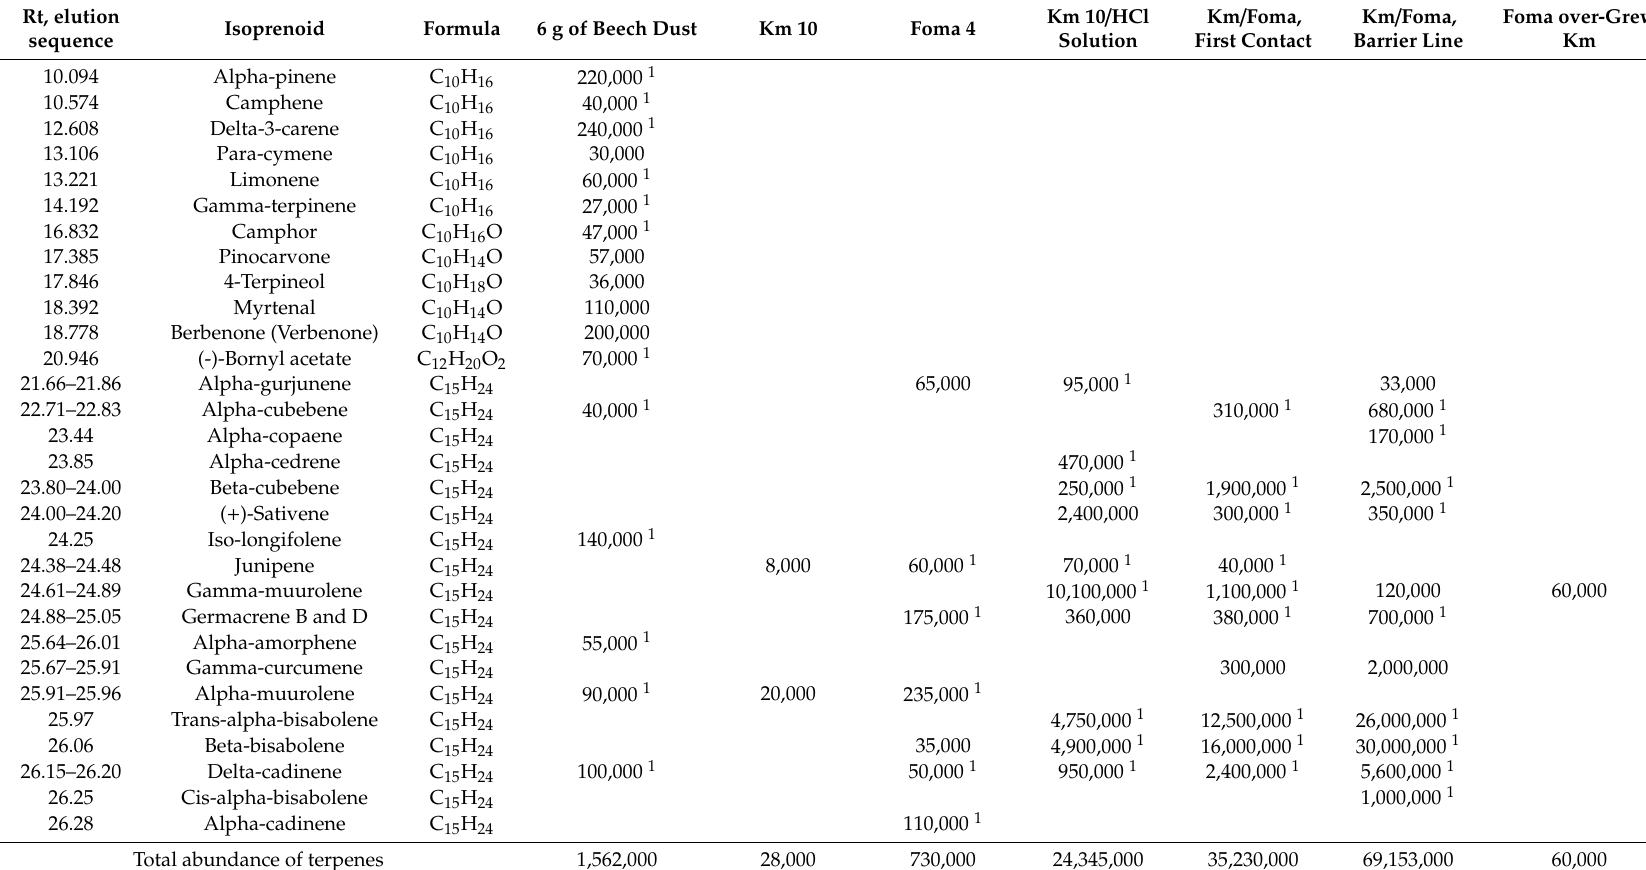
Table 3. Tentative and confirmed identification of the main terpenes released within 24 h by monoxenic and dual fungal cultures of Km 10 and Foma 4 growing on 6 g of fertilized beech wood dust in 0.3-L glasses. Volatiles were arranged in the approximate sequence of elution. Values represent relative maximum abundances displayed within 24 h from 2 to 3 replicate samples. Blanks are compounds that were absent or in identity below the probability level of